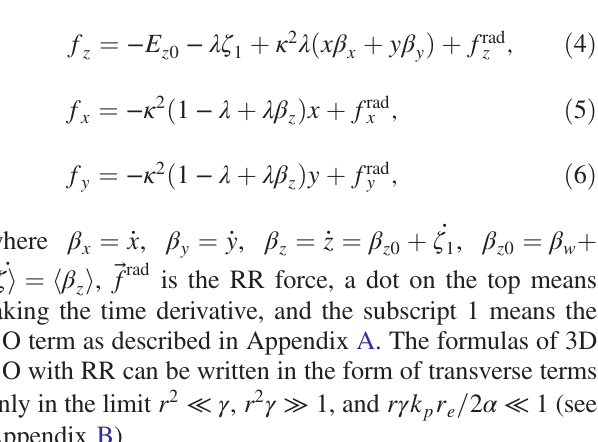
TABLE I. The plasma normalization units. Physical quantities